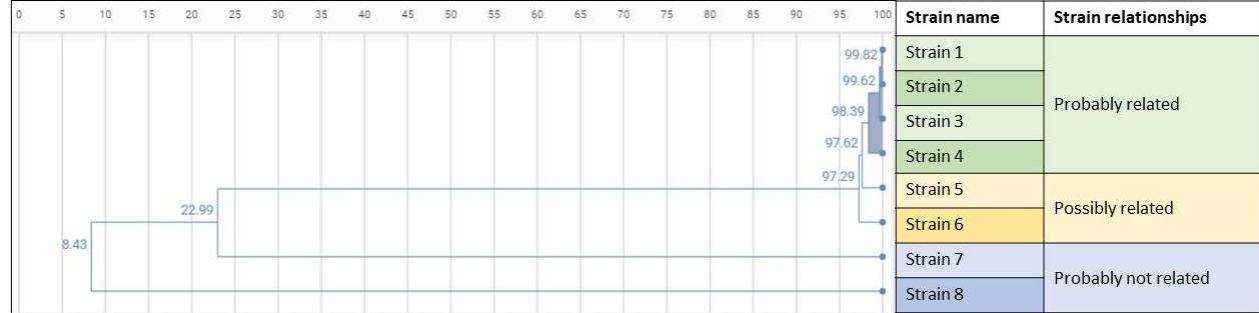
Figure 3. Dendrogram. High and low similarity coefficient cut-offs were established at >98% and 95%, respectively. Four isolates were classified as probably related and formed Cluster 1. Two isolates were considered possibly related and another two isolates were considered probably not related.